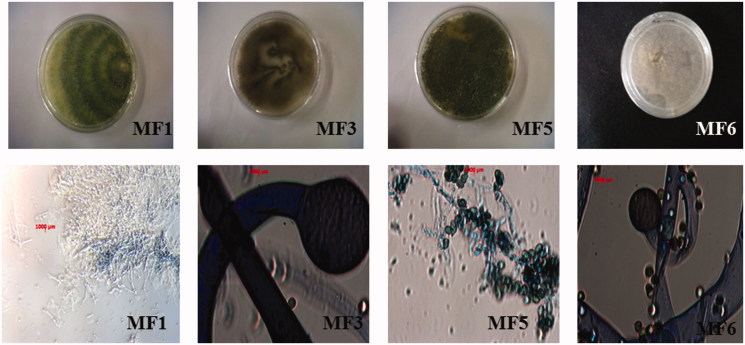
The morphology (colony appearance, fruiting structures and spores) of identified endophytic fungi isolated from the leaves of Markhamia tomentosa.